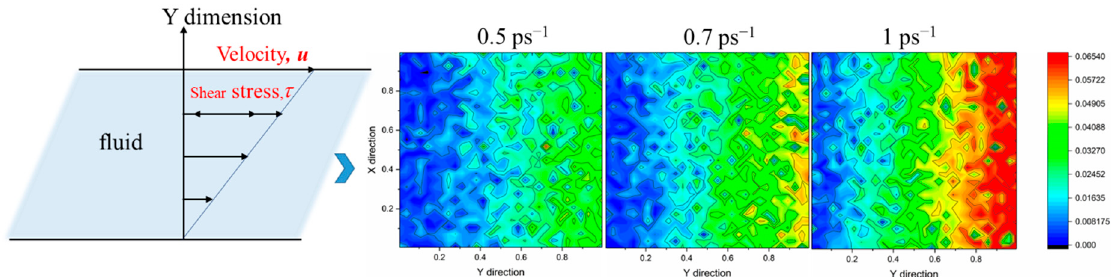
Figure 11. The velocity distribution of Couette flow and the velocity distribution of the system under the NEMD method.